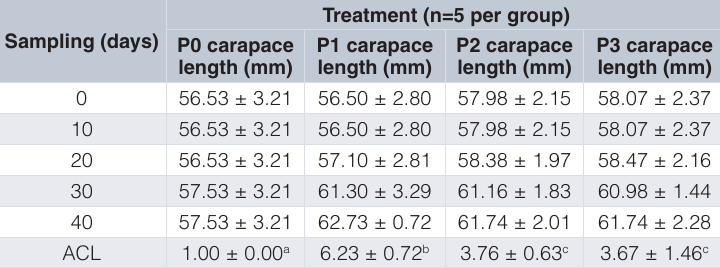
Table 3. Average carapace length (mm) and absolute carapace length (mm) of female broodstock blue swimming crabs, P. pelagicus (Linnaeus, 1758), with a formulated diet of vitamin E supplementation at different